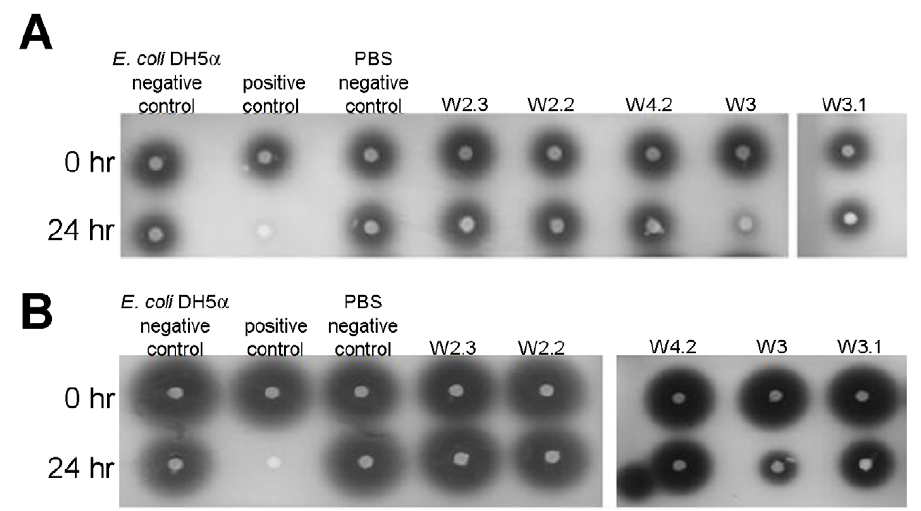
Figure 6. Degradation of AHLs by isolated strains. Residual C4-HSL (A) and C6-HSL (B) were detected by C. violaceum CV026. Decreased or loss of violacein indicated AHL inactivation after incubation for 24 h. B. cereus known for carrying a lactonase was used as positive control. E. coli DH5 a and PBS served as negative controls.